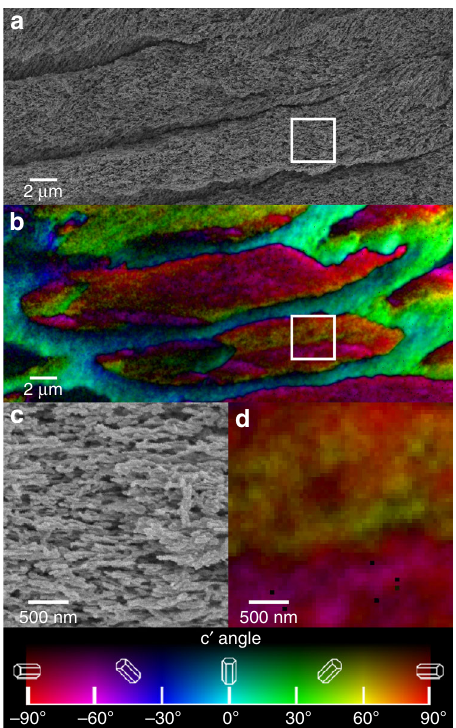
Fig. 3 Comparison of SEM image and PIC map of the same region of human enamel. a The SEM image, acquired after etching, reveals two well-distinct rods, separated by interrod and deeper groves, and surrounded by other partial rods. b The PIC map shows that the same two well-distinct rods have multiple orientations within them, as all other rods imaged in this work. Since the bottom has more diverse orientations, we chose this rod to zoom-in further in ( c ) and ( d ), where the white boxes are located in ( a ) and ( b ) respectively. c Zoomed-in SEM image showing that all crystals are approximately horizontal and parallel to one another. d Zoomed-in PIC map showing that crystals from top to bottom of the box vary from red, to orange, to green in the top half, which is a 60° angle spread, and from red to magenta in the bottom half, which is a 30° angle spread. See Supplementary Figs. 4 and 5 for the exact position of this area in the tooth, and for the SEM image warping necessary to overlap precisely the bottom rod in the PIC map. This warping makes the top rod imprecisely correspond to the top rod in the PIC